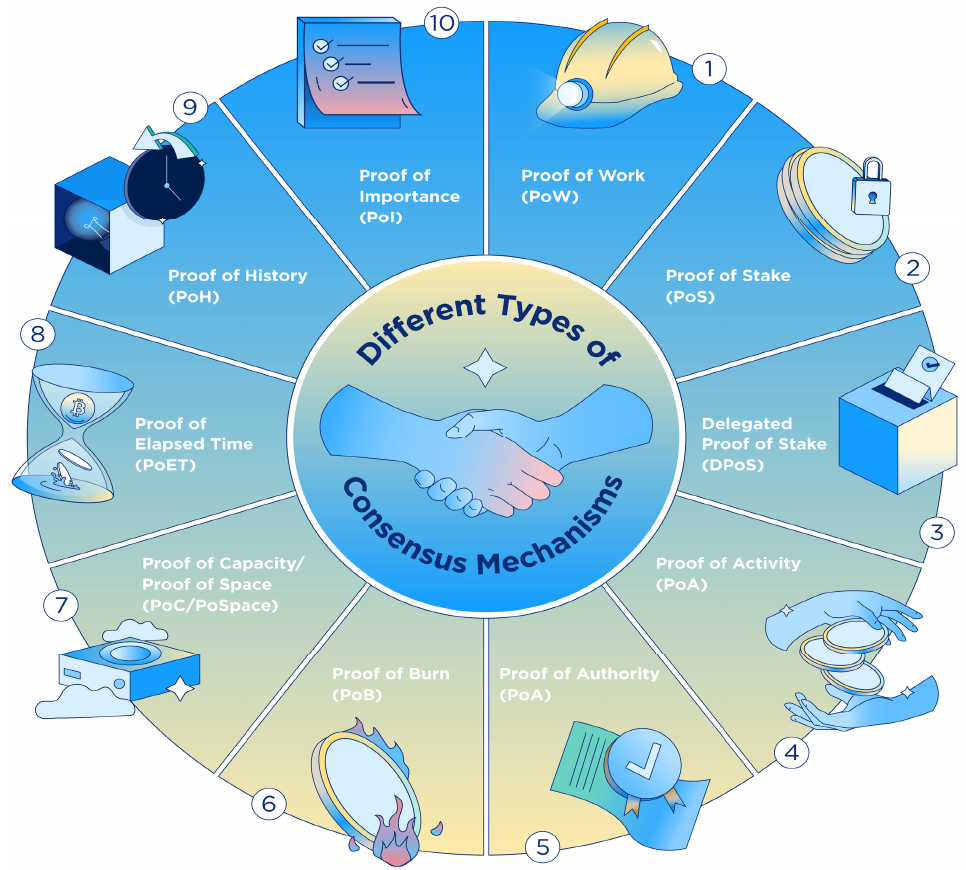
Figure 8. Consensus Mechanisms in Blockchain Technology [13] .